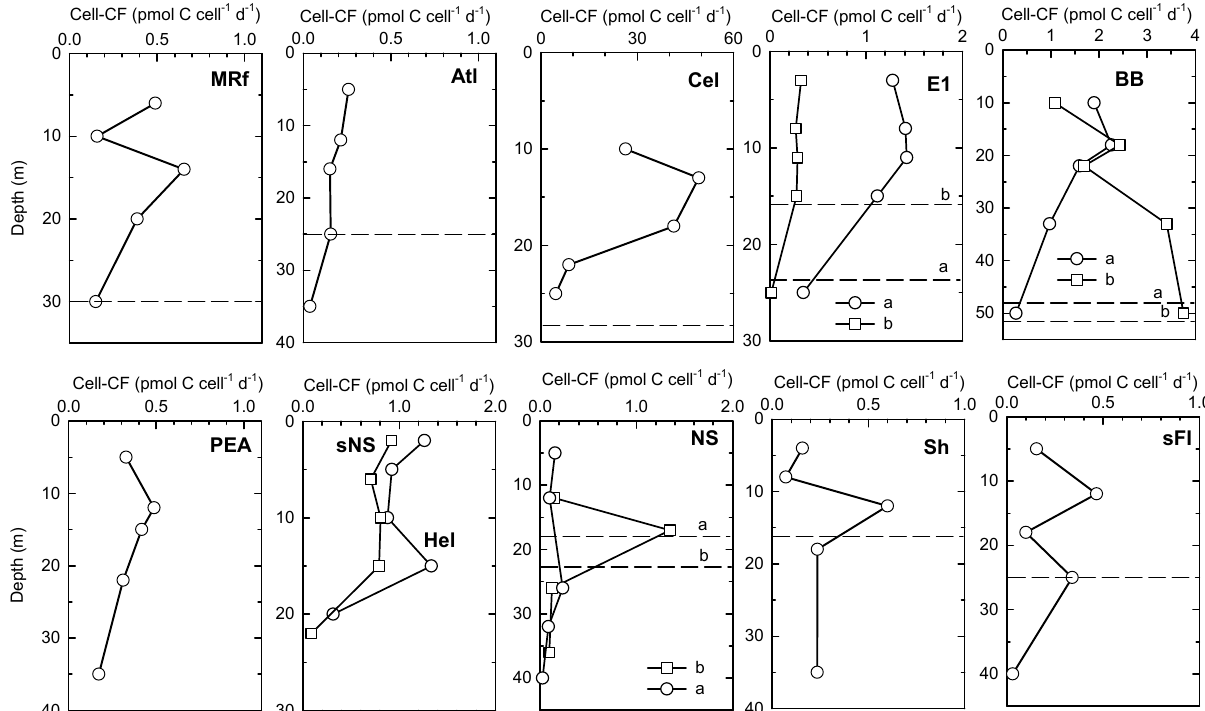
Figure 6. Vertical profiles of cell-normalised calcite production (cell-CF, pmolCcell − 1 d − 1 ) over the euphotic zone. Dashed line indicates mixed layer depth